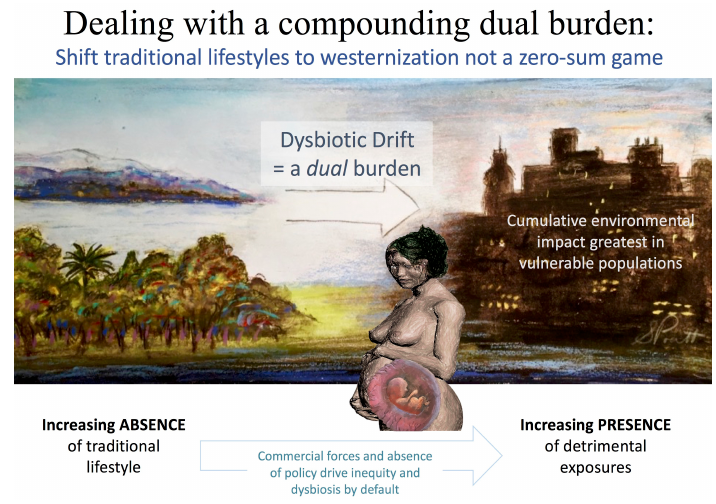
Figure 1. Dysbiosis (defined as “life in distress“) is the result of the modern environmental changes that are adversely affecting all ecosystems, progressively displacing “green space“ with “grey space“ and creating conditions that erode physical, mental and societal health from the first moments of life. This dual burden is compounded and exacerbated by the greyspace environment that perpetuates unhealthy behaviour, with lifelong effects. Commercial forces and absence of policy drive inequity and dysbiosis by default.